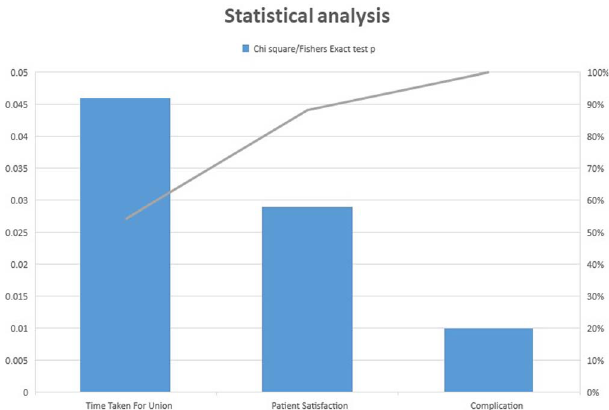
Figure 5. Patient satisfaction and